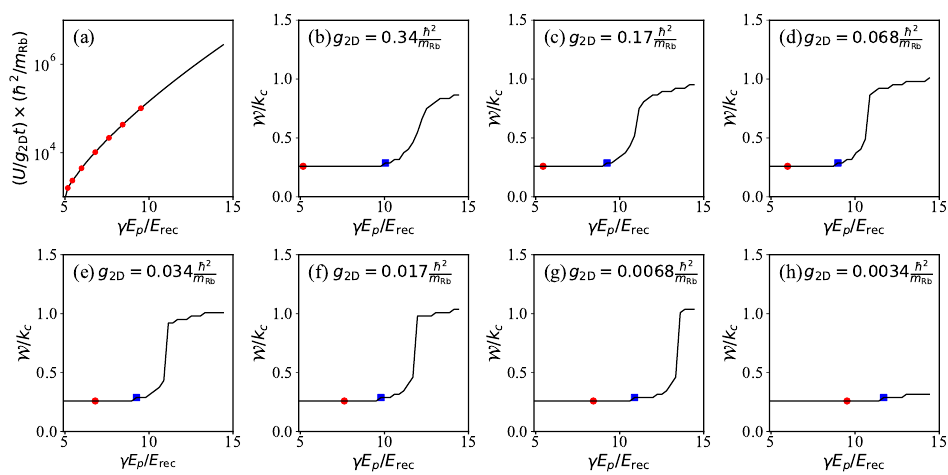
t as a function of Figure 9: (a) The ratio of the Bose-Hubbard parameters U / g 2D the pump strength E calculated using the MLGWS package [ 80 ] . The red squares p ≈ 290 [ cf. Eq. (23) ] for different indicate the predicted Mott transition point ( U / t ) c / ħ h 2 = 0.34, 0.17, m values of contact interaction strength: (from left to right) g 2D Rb 0.068, 0.034, 0.017, 0.0068, 0.0034. (b-h) The width W of the central peak in the momentum space as a function of pump strength E for different values of contact p interactions g simulated using MCTDH-X. The Mott transition is determined by the 2D onset of the increase in W , and is indicated in the figures by the blue squares. The Mott transition points predicted in panel (a) are also shown in the corresponding panels (b-h) as red